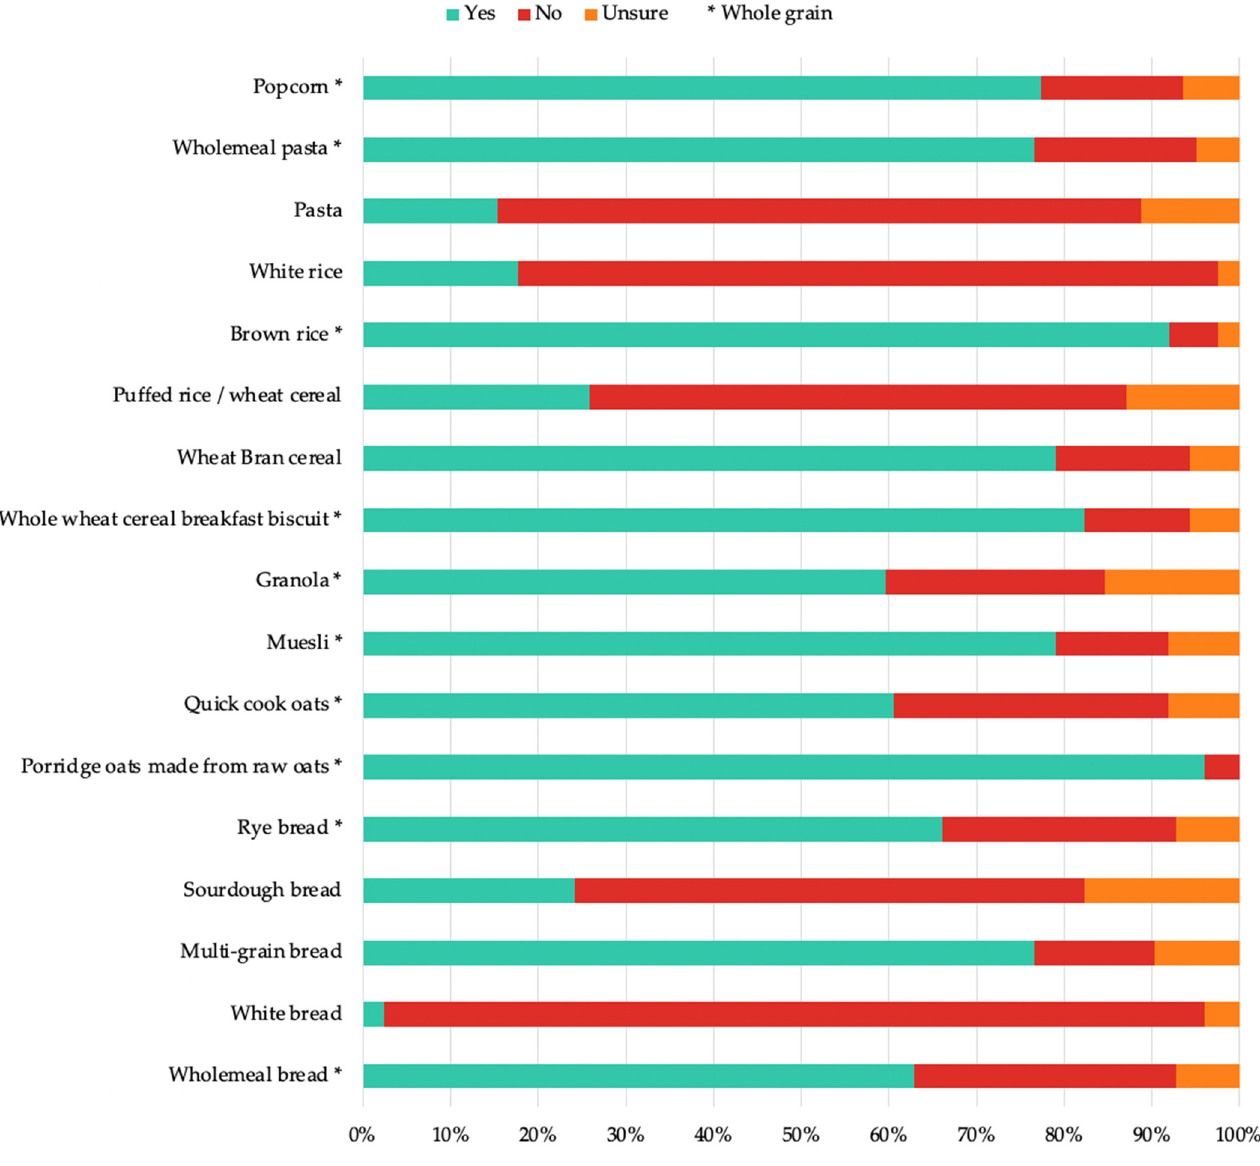
Figure 1. Identification of whole-grain- and non-whole-grain-containing foods by dietitians. *: indicates that the food is whole-grain.